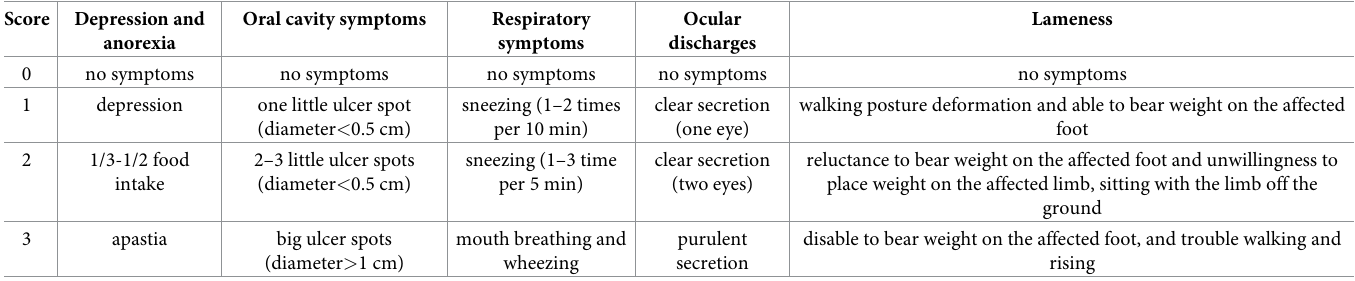
Table 2. Standard for assessing clinic